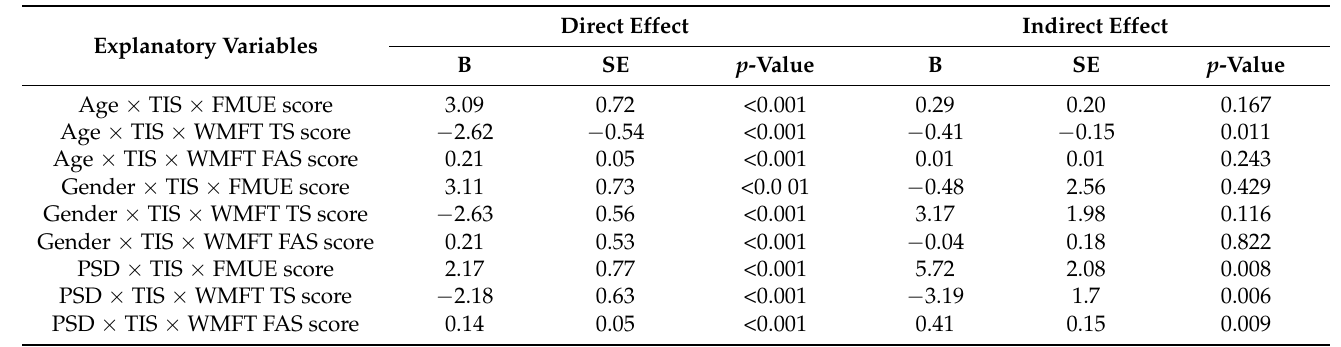
Table 2. Direct effects of trunk control on upper extremity impairment and functions with the effect of age, gender, and post-stroke duration.